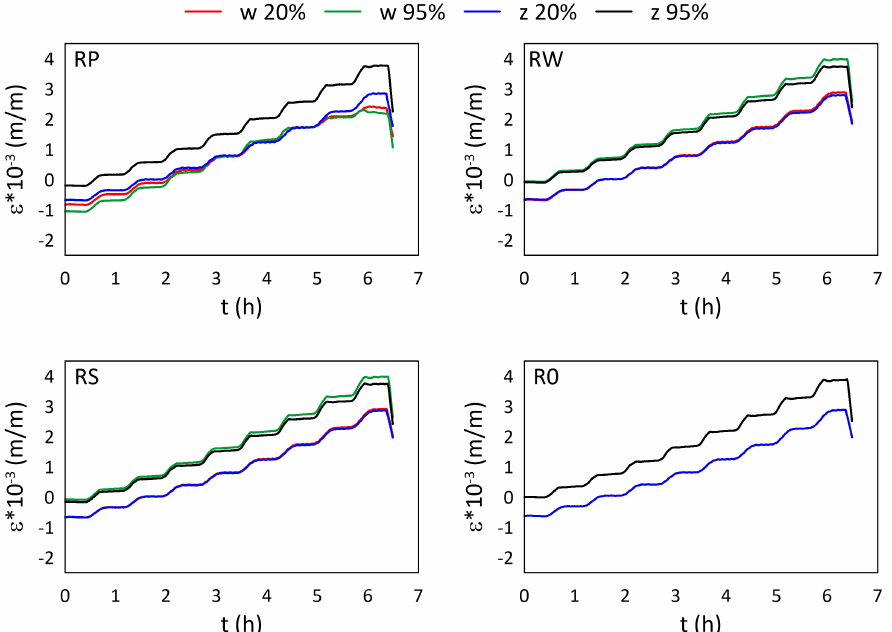
Figure 5. Strain measured by FBG sensors for M3 X samples under elevated temperatures; FBG sensors: w —embedded, and z —attached.